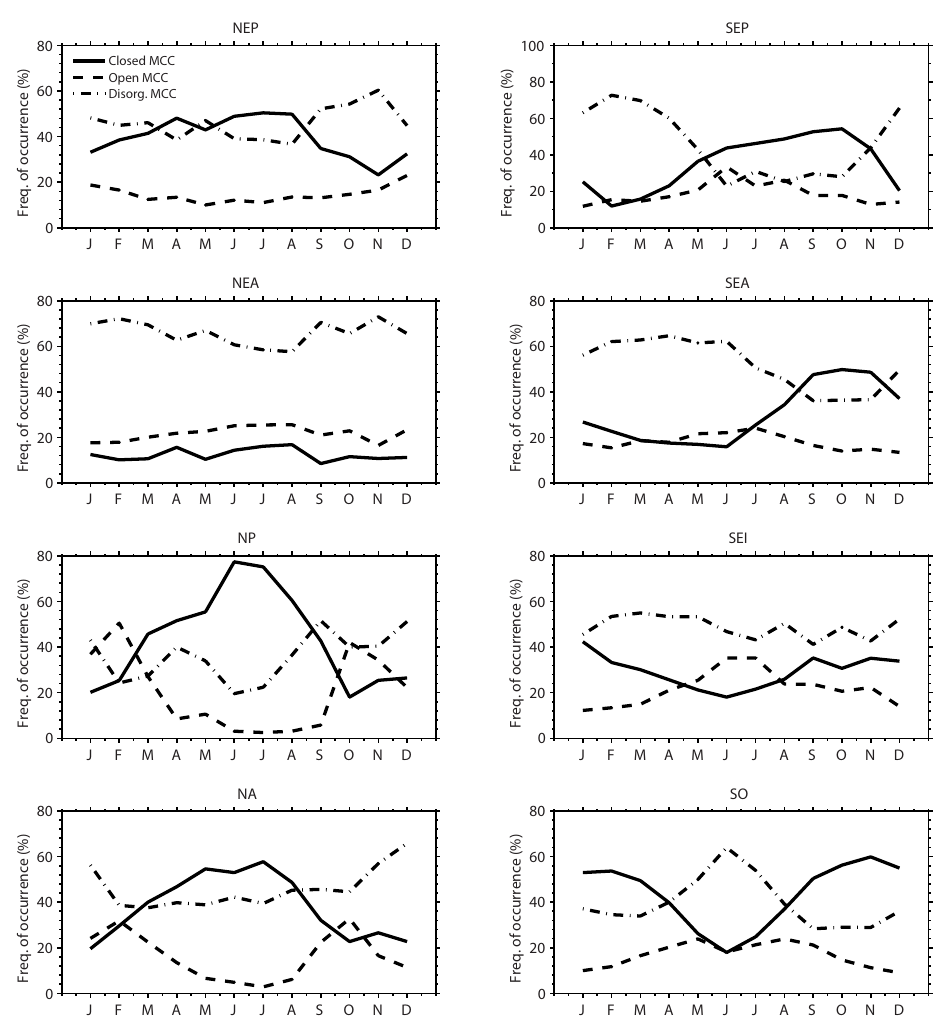
Figure 6. Same as Fig. 3 but for the seasonal cycle of the frequency of occurrence of MCC types. Shown are closed MCC (solid), open MCC (dashed) and cellular but disorganized MCC